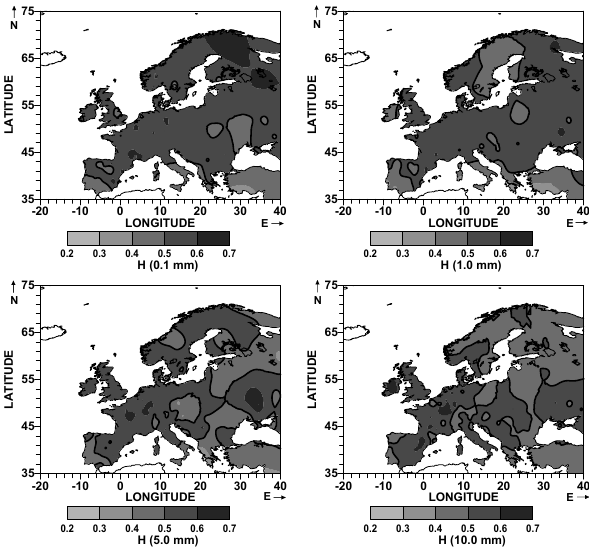
Fig. 6. Spatial distribution of the Hurst exponent for the four thres- holds (0.1, 1.0, 5.0 and